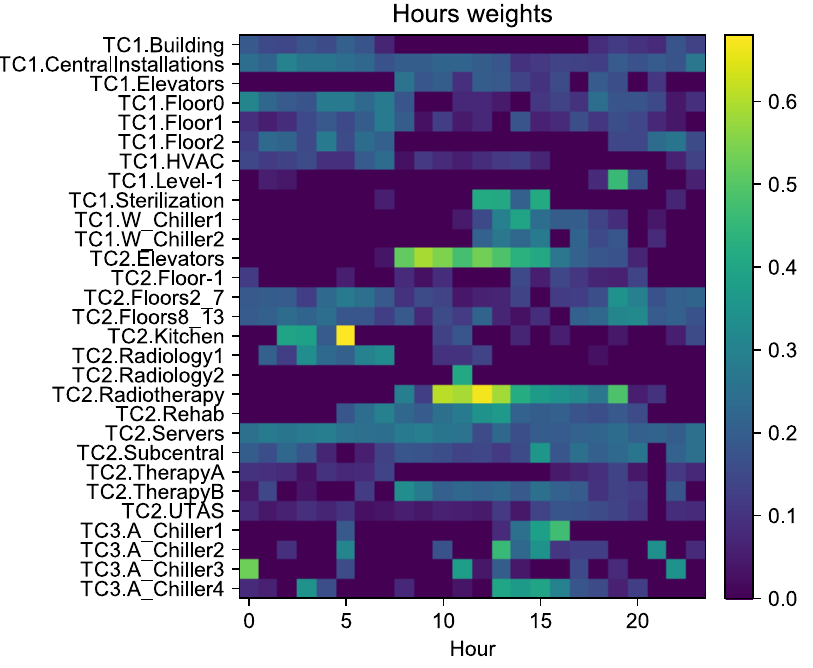
Figure 8. Heatmap showing the weights of the depthwise convolution. Blue colors correspond to low values near zero and yellow ones to high